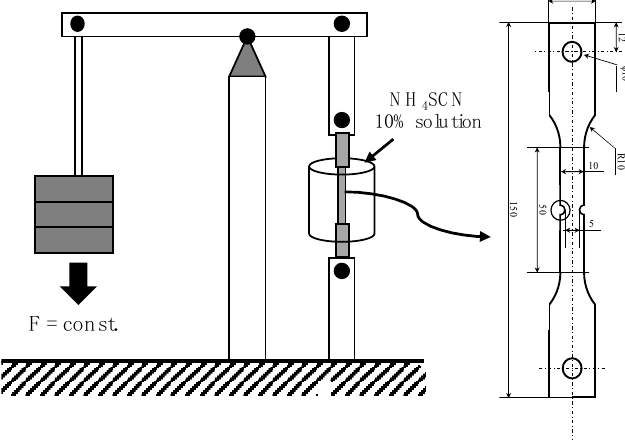
Figure 3. Experimental setup and geometry of notched tensile sample used for delayed cracking testing under constant load conditions.